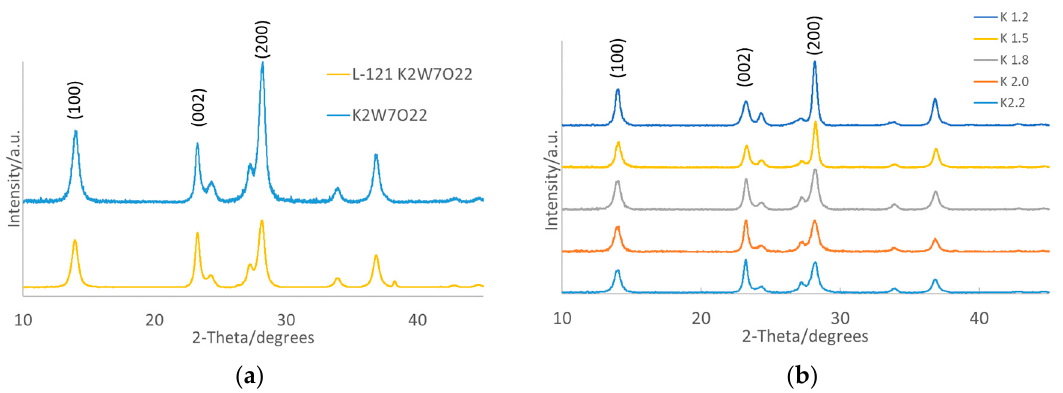
Figure 1. XRD of K x WO grown ( a ) with and without L-121 surfactant and ( b ) with x = 1.2, 1.5, 1.8, 2.0, and 2.2.